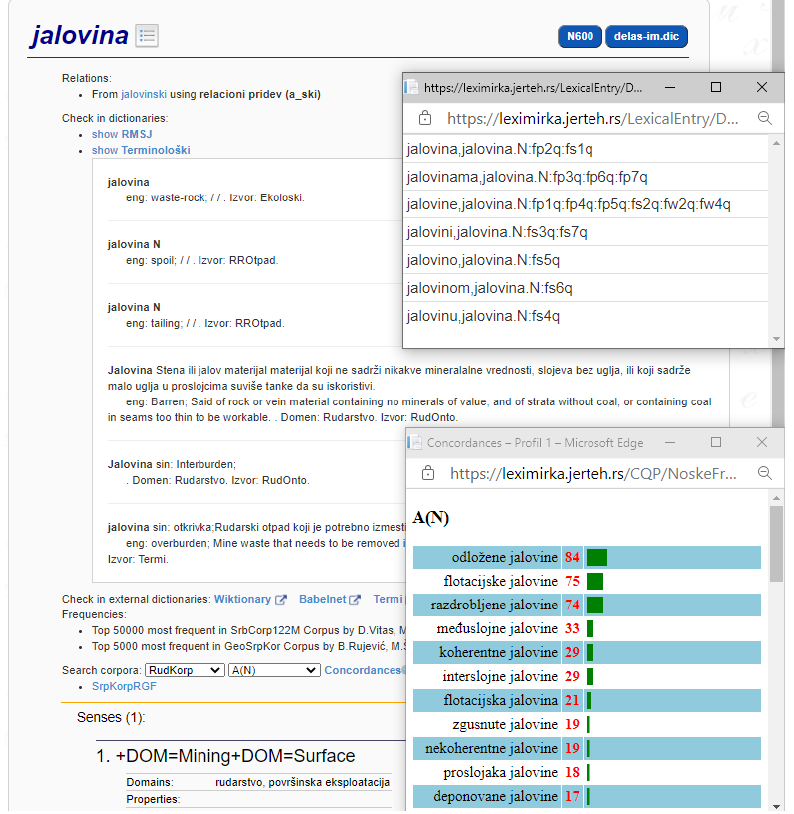
Figure 5. The Leximirka app for lexical database